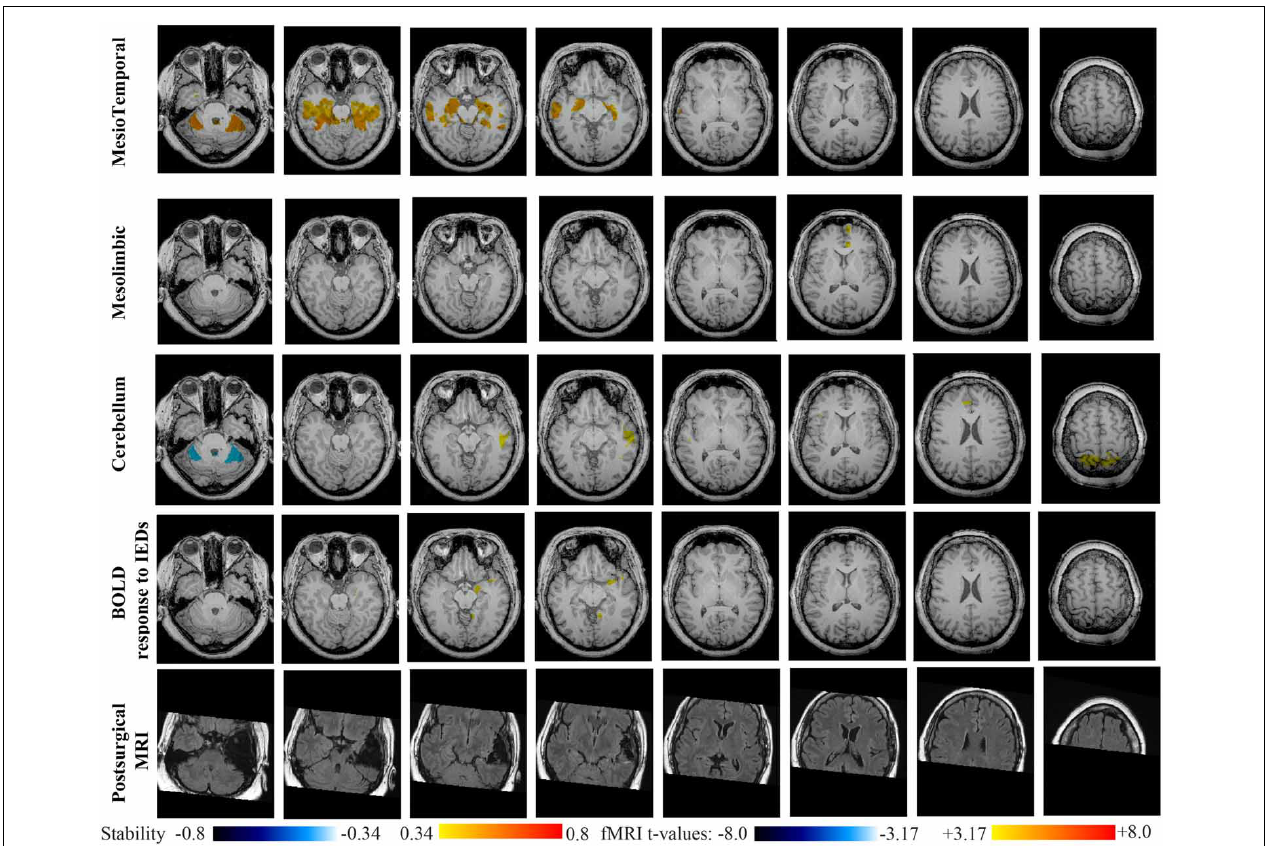
FIGURE 9 | Evaluation of DANI on Patient 4 with right MTLE. Results are presenting most salient stability changes observed in Cmap n followed by a t -map of the BOLD response to epileptic discharges and a postsurgical FLAIR MRI, all resampled in the native anatomical MRI space of the patient. Most salient stability